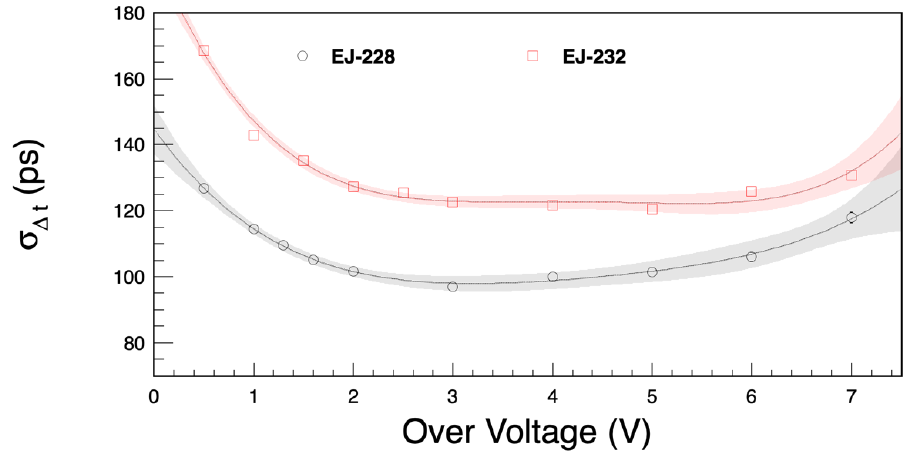
Figure 9. Comparison between Eljen-228 and Eljen-232. The overvoltage was varied from 0.5 V to 7 V at a fixed discriminator threshold of 10 mV and an environmental temperature of + 23 ◦ C. The gray and red error bands indicate the 95% confidence level of the